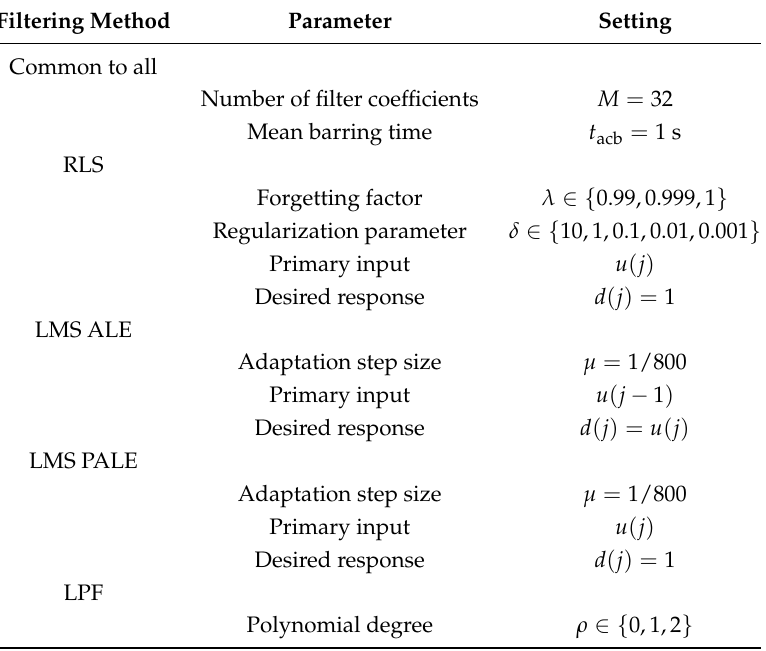
Table 3. Parameters for the selected filter